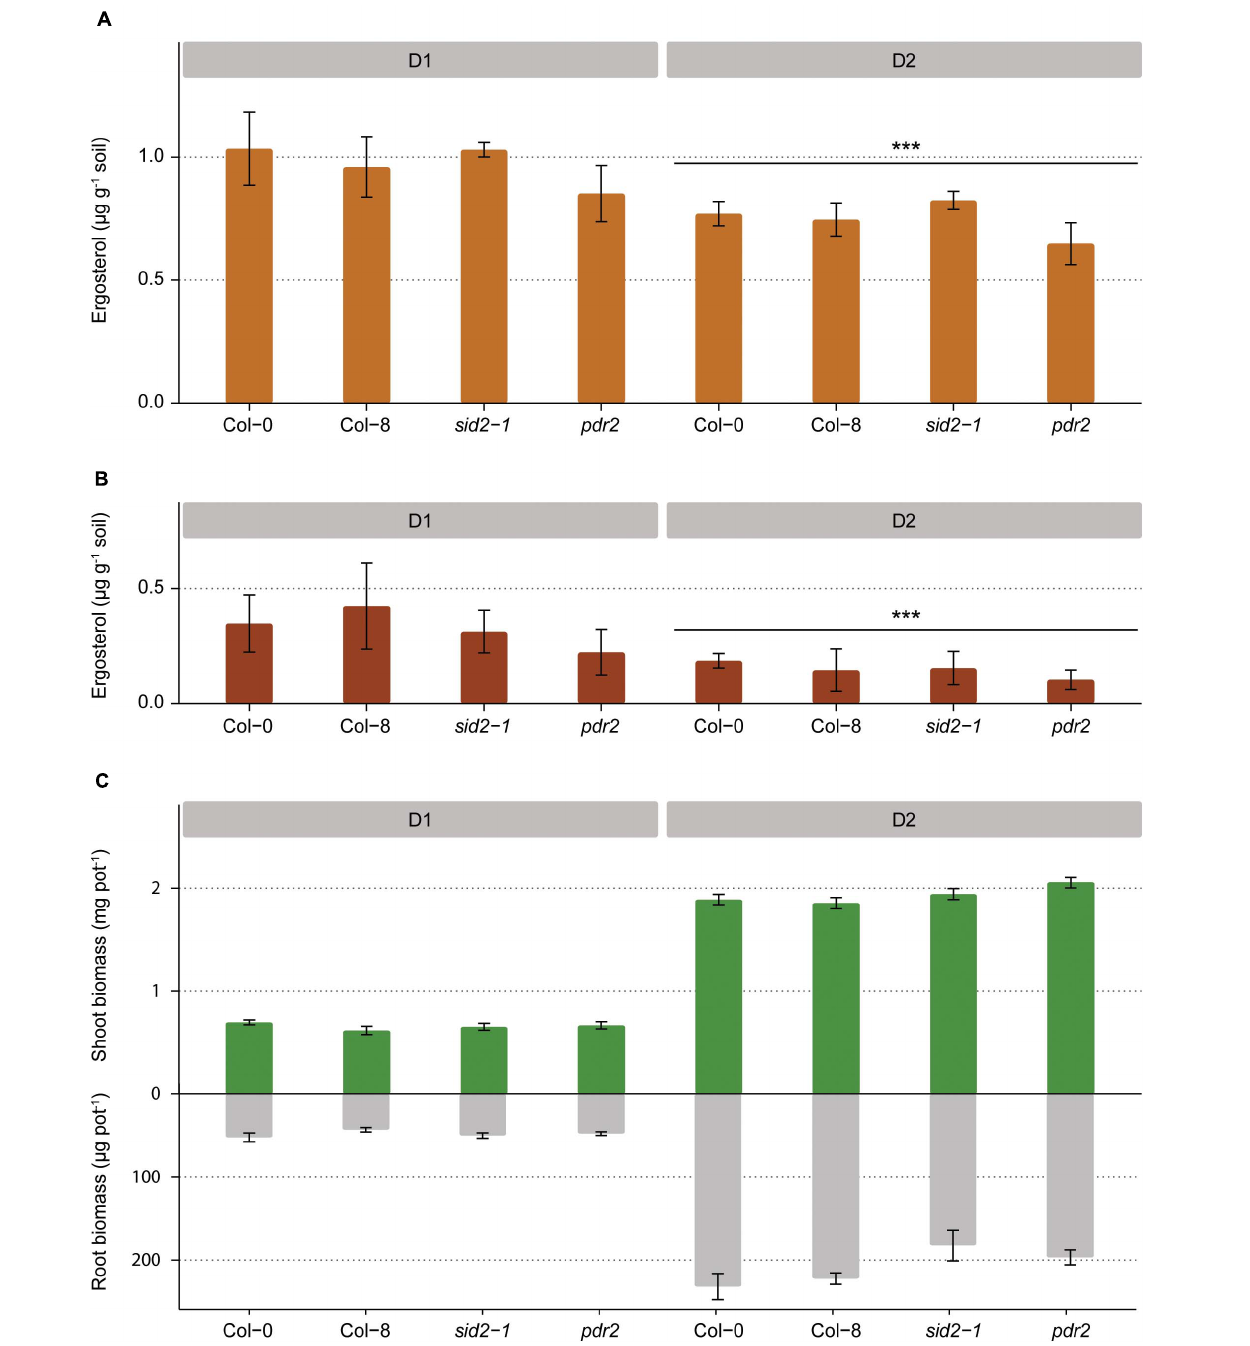
FIGURE 4 | Fungal biomass in the rhizosphere soil of four Arabidopsis lines at two developmental stages (D1 and D2) measured as ergosterol concentration (A) and increase in ergosterol concentration from the level measured in the bulk soil (B) . Aboveground and belowground dry plant biomass collected from each pot for four Arabidopsis lines at two developmental stages (C) (*** p <